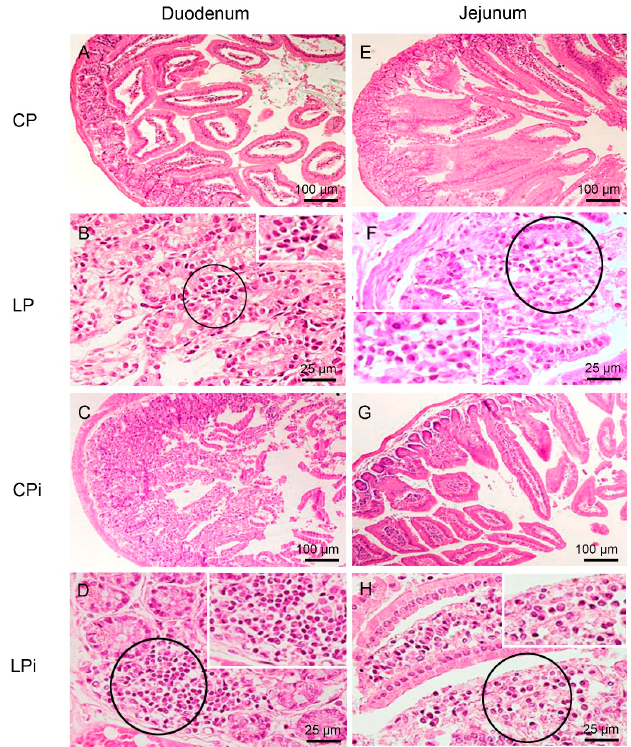
Figure 2. Histopathological analysis of duodenum and jejunum from BALB/c mice. CP: animals fed 14% protein diet, LP: animals fed 4% protein diet, CPi: animals fed 14% protein diet and infected, LPi: animals fed 4% protein diet and infected. ( A – D ) Duodenum. H&E. ( A ) CP mouse without histological alterations. ( B ) LP mouse showing mild and focal lymphocytic infiltrate (circle and inset) in the lamina propria. ( C ) CPi mouse showing moderate to severe and diffuse lymphocytic infiltrate in the lamina propria. ( D ) LPi mouse showing moderate to severe and diffuse lymphoplasmacytic infiltrate (circle and inset). ( E – H ) Jejunum. H&E ( E ) CP mouse without histological alterations. ( F ) LP mouse showing mild and focal lymphocytic infiltrate (circle and inset) in the lamina propria. ( G ) CPi mouse without histological alterations. ( H ) LPi mouse showing moderate to severe lymphoplasmacytic infiltrate (circle and inset) in the lamina